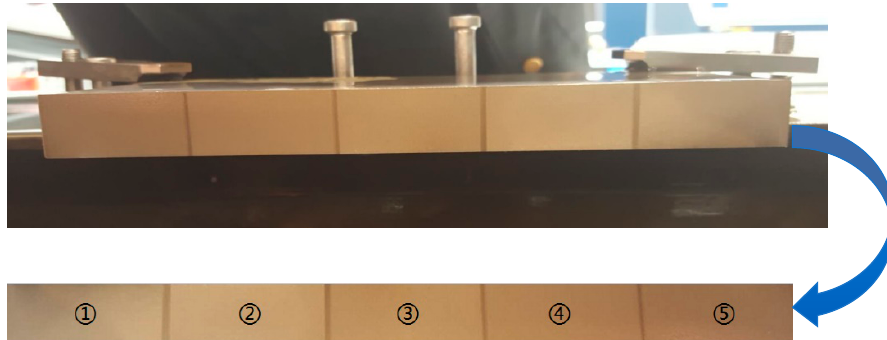
Figure 2. Regions on the workpiece during the experiments as a function of wire infeed.